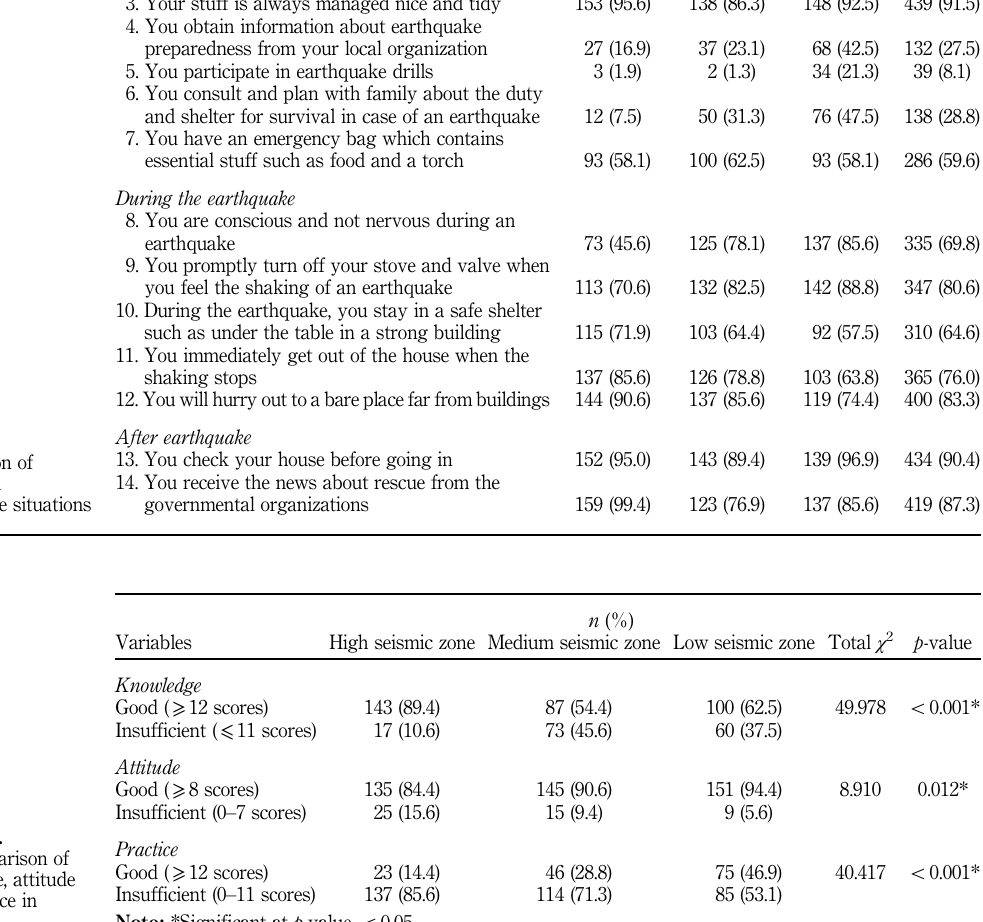
knowledge, attitude and practice in each